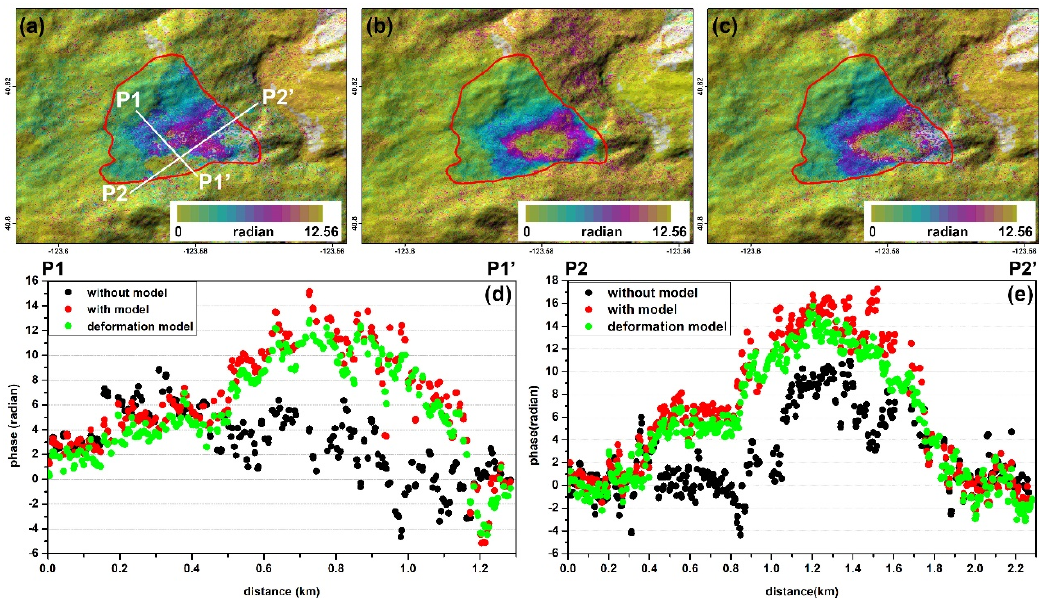
Figure 3. An example of unwrapping error correction based on a deformation model. ( a ) The original unwrapped phase of a 364-day interferogram (e.g., 20150922–20160920 for P68). ( b ) The corresponding deformation model constructed from a stack of correctly-unwrapped short-duration interferograms. ( c ) The new unwrapped phase with the aid of deformation model. ( d ) and ( e ) show the unwrapped phase extracted along the profile P1P1’ and P2P2’, respectively. The red polygon shows the boundary of the active landslide and the white lines represent the location of the profiles.